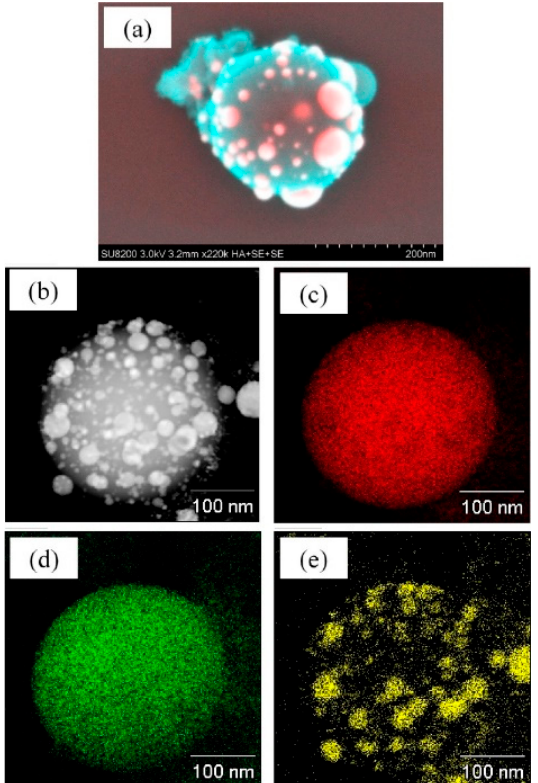
Figure 5. ( a , b ) Transmission electron microscopy showing Au-TiO 2 core–shell bimetallic nanoparticles synthesised via pulsed laser ablation in liquid; chemical composition of bimetallic nanoparticles showing ( c ) titanium, ( d ) oxygen, and ( e ) gold [2].